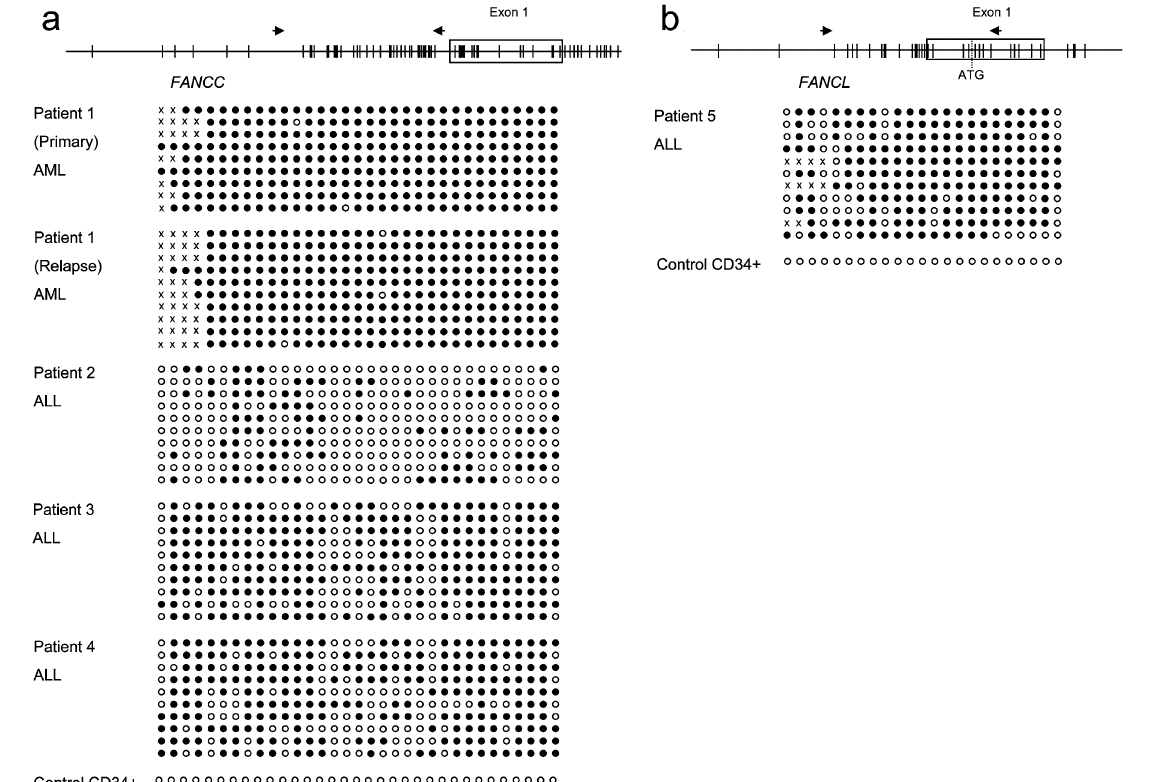
Fig. 2. Bisulphite sequence analysis of the FANCC and FANCL promoter regions in primary leukaemic samples. (a) Upper part: schematic representation of the FANCC gene’s promoter region. The 33 assessed CpGs are situated upstream of exon 1, between the arrows; the translation start is in exon 2 (not shown). In the lower parts of the figure each row represents an individually cloned and sequenced allele following sodium bisulfite DNA modification, black and open circles representing methylated and unmethylated CpGs, respectively. Sequence data for a number of CpGs were ambiguous, indicated by an x. Arrows indicate sequences complementary to the primers used (patient 1, adult diagnosed with biphenotypic AML, patients 2, 3 and 4, paediatric patients diagnosed with ALL). (b) Methylation status of the 23 assessed CpGs in the promoter region of the FANCL gene, represented as described above. The translation start of the FANCL gene is located in the first exon (patient 5, adult diagnosed with